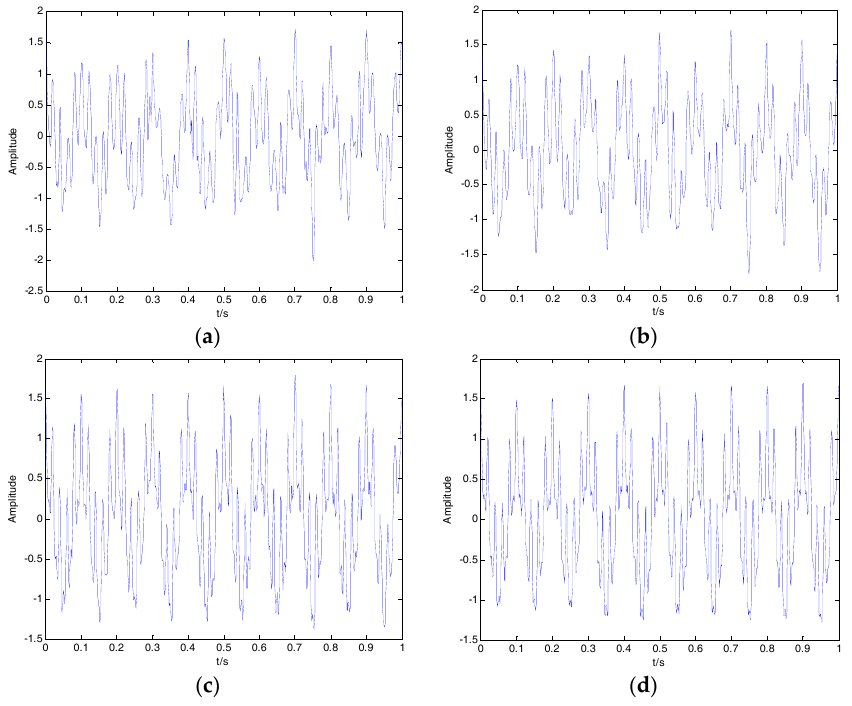
Figure 6. The denoising results of EMD, EEMD, VMD and 2VMD for the noisy signal. ( a ) EMD; ( b ) EEMD; ( c ) VMD; ( d ) 2VMD.